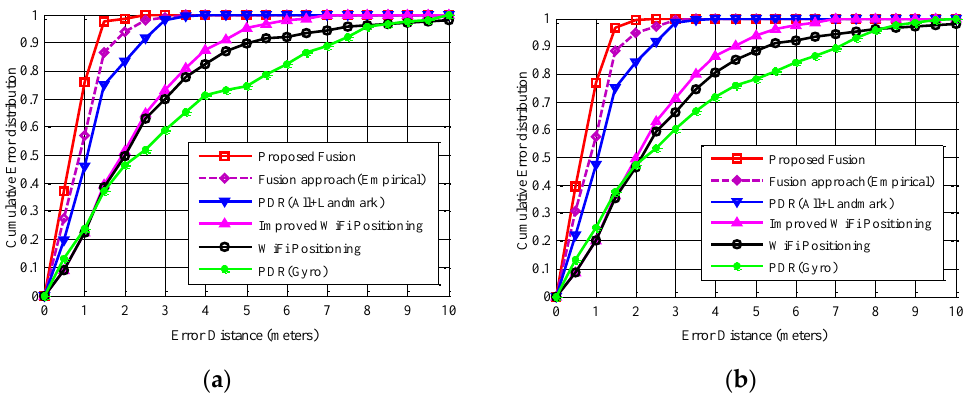
Figure 8. Accuracy comparisons between the proposed fusion approach, fusion approach (Empirical), PDR (All+Landmark), PDR (Gyro), WiFi positioning, and the improved WiFi positioning: ( a ) path one; ( b ) path two.